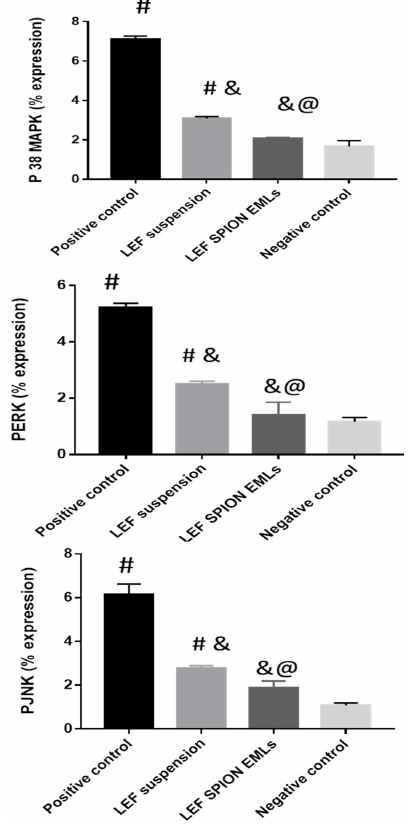
Figure 8. PERK 1/2, PJNK, and P38 MAPK levels assessed by PCR in dissected joints. Values are expressed as mean ± SD; n = 3. Statistical analyses were performed using one-way analysis of variance (ANOVA) followed by Tukey’s post hoc test. # significant as compared to negative control group. & significant as compared to positive control group. @ significant as compared to LEF suspension. Significant difference was conducted at p < 0.0001.